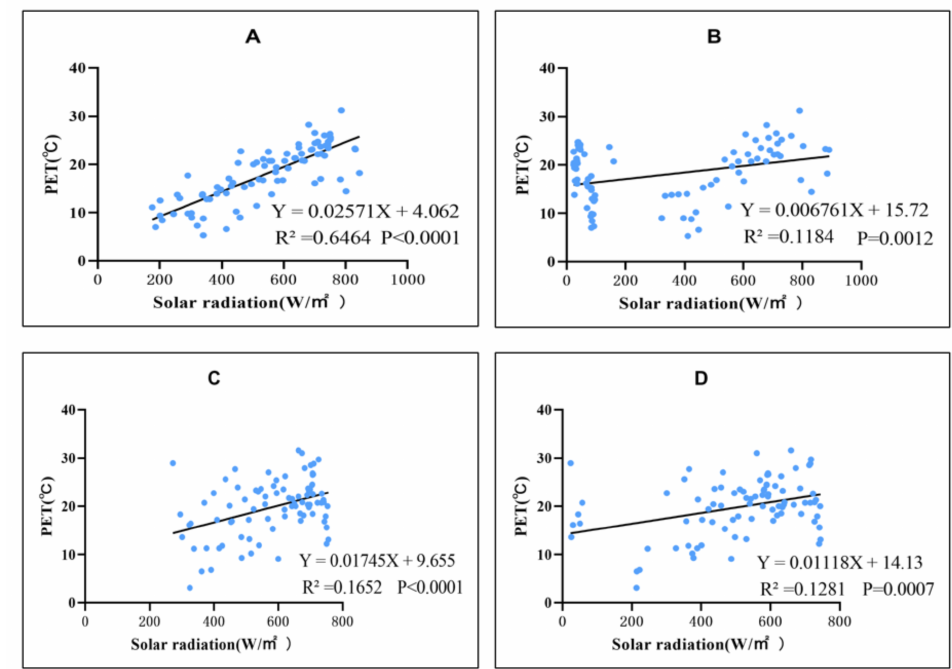
Figure 13. The relationship between PET and solar radiation at different courtyards. (( A – D ) respec- tively represent the number of the courtyard under